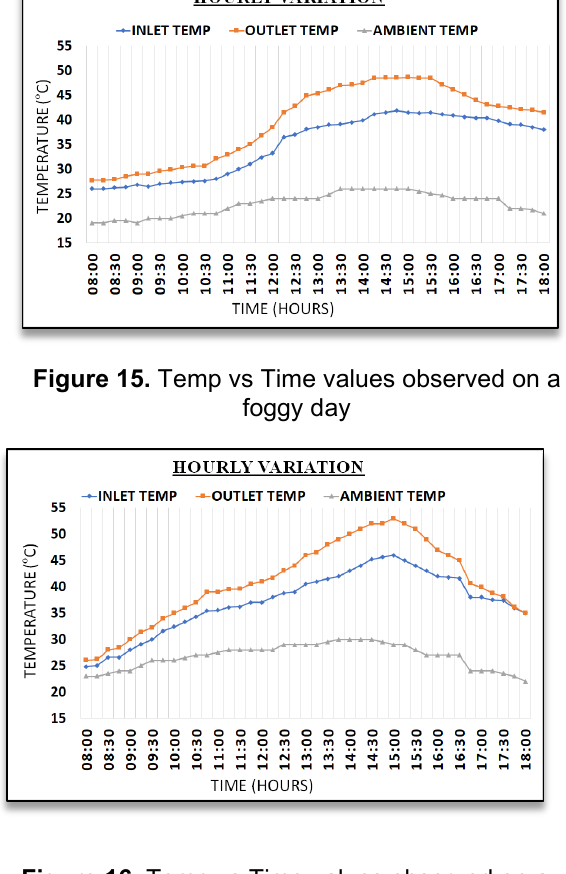
Figure 16. Temp vs Time values observed on a foggy day with sunny day